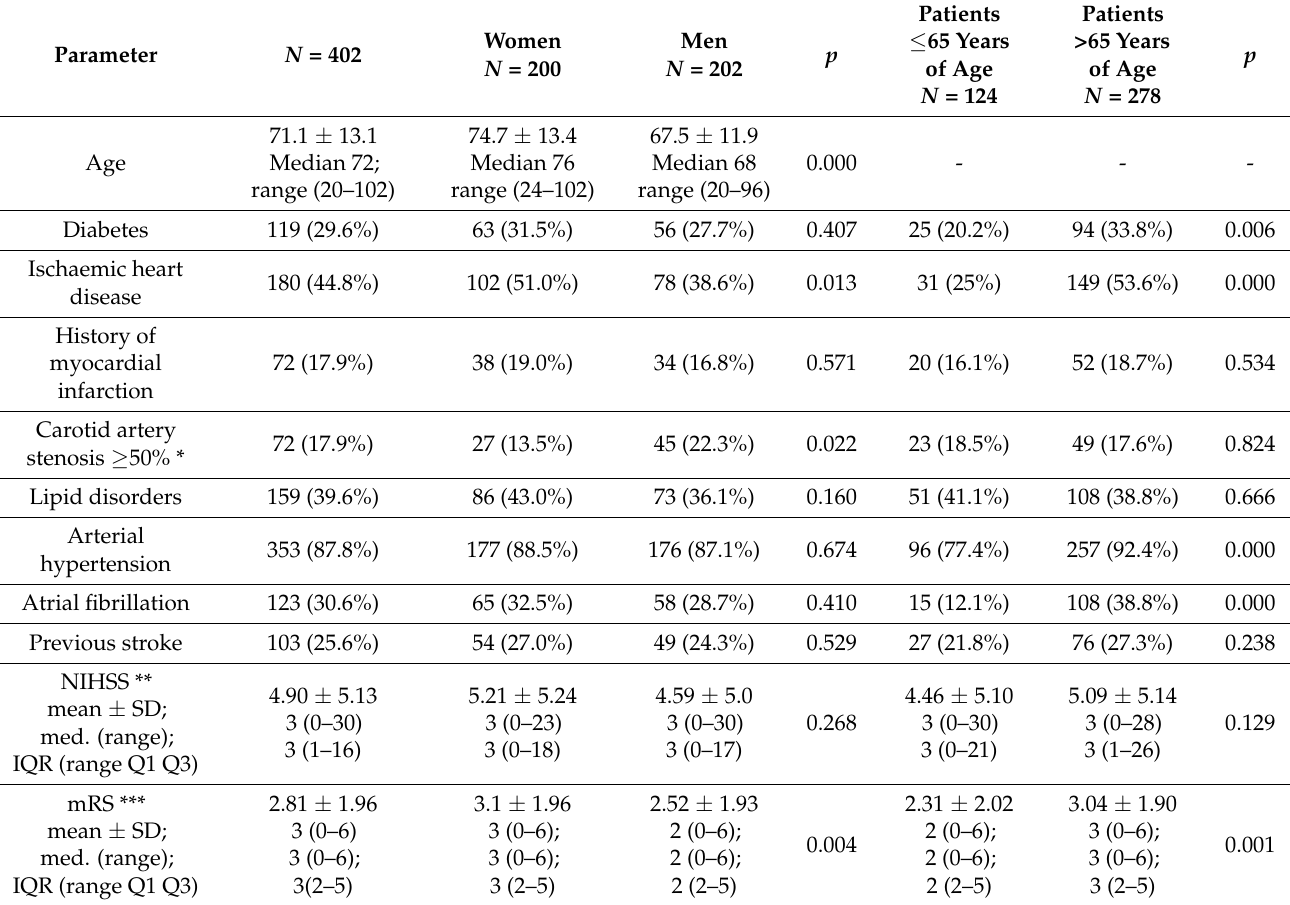
Table 1. Demographic and clinical features of